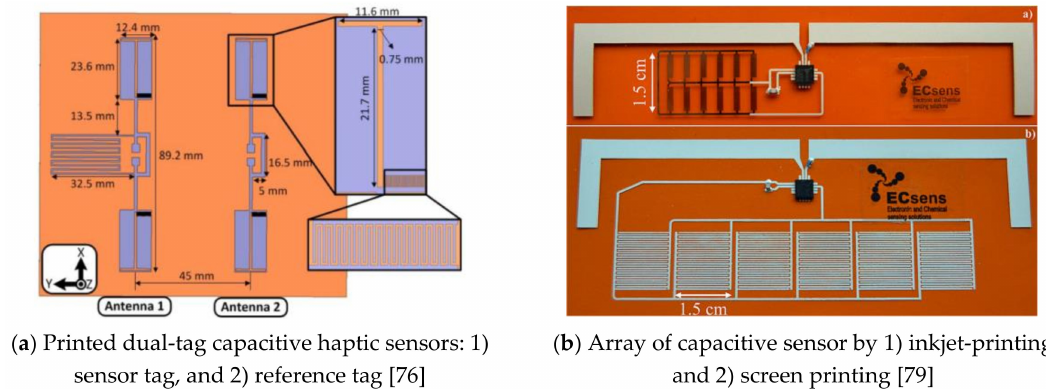
Figure 9. Inkjet Printed RFID